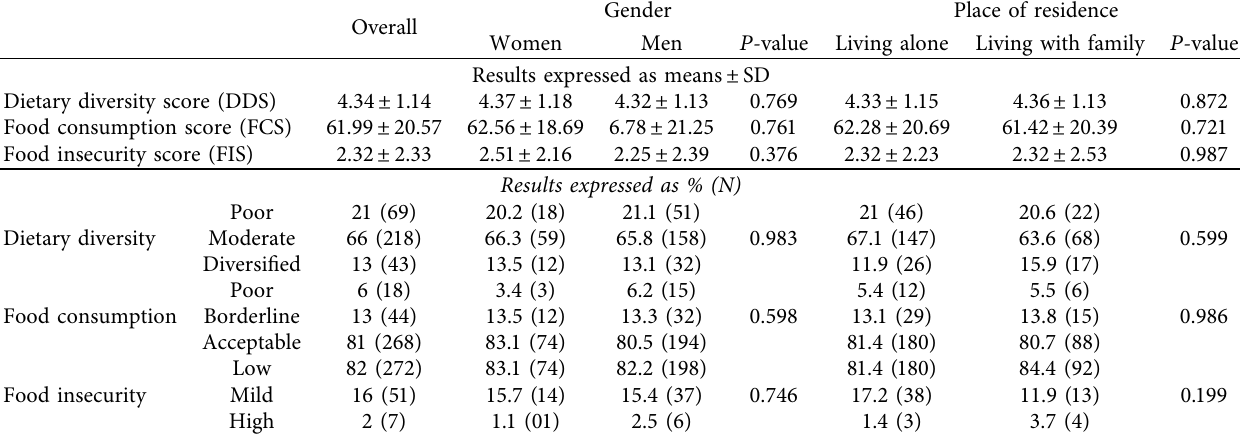
Table 7: Dietary diversity, food consumption, and food insecurity among study participants.